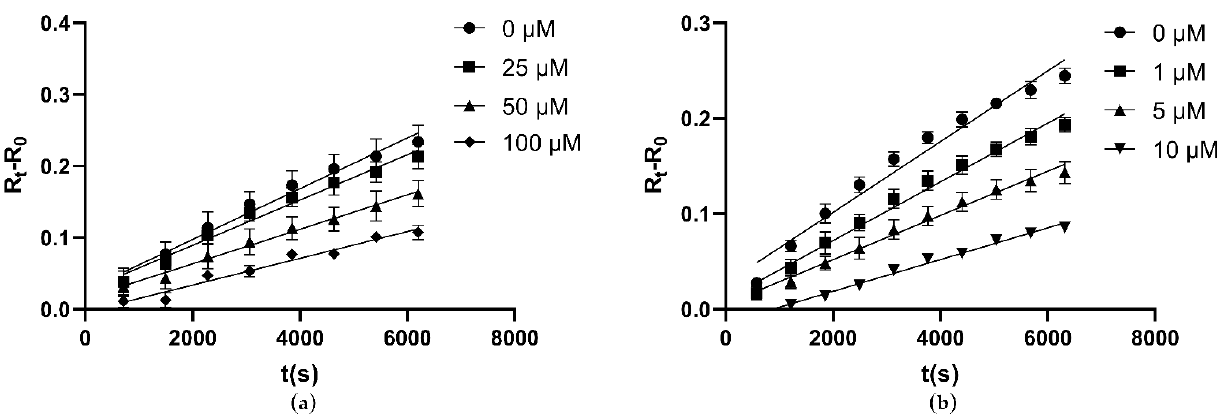
Figure 4. Folic acid and AZD1152 reversibly inhibit C Las GMPS. Elongating the reaction time, no exponential enzyme decay observed. Substrate concentrations are 1 mM ATP and 2 mM Glutamine for C Las GMPS. ( a ) Folic acid; ( b ) AZD1152.